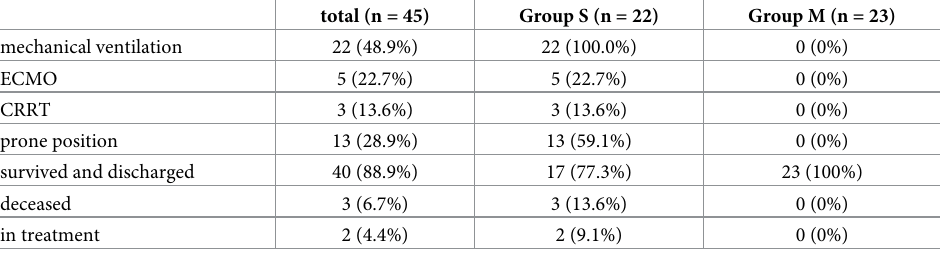
in treatment 2 (4.4%) 0 (0%) ECMO: Extracorporeal membrane oxygenation; CRRT: continuous renal replacement